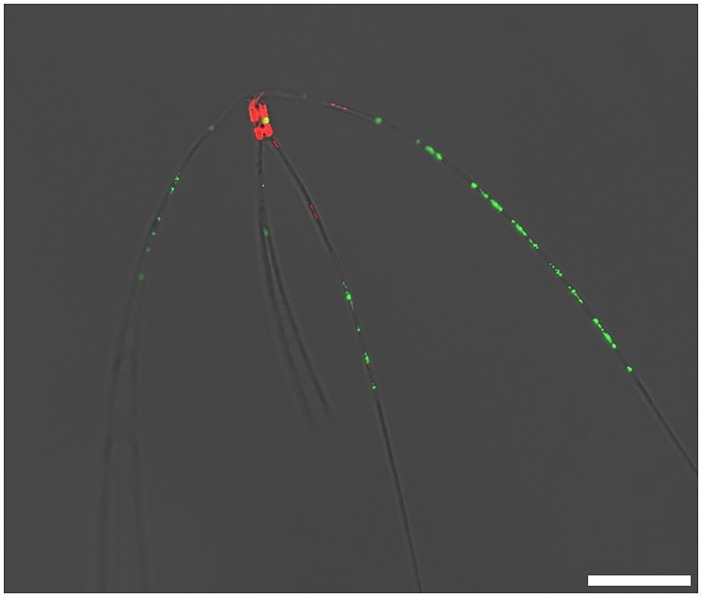
C. peruvianus cell from a culture in P-limit medium after incubation with alkaline phosphatase substrate from the ELF 97 Phosphatase Detection Kit.Chloroplast autofluorescence is shown in red. The fluorescent signal from dephosphorylated alkaline phosphatase substrate is shown in green. It accumulates at the location of alkaline phosphatase activity, along the setae of the cell. Scale bar represents 20 μm.